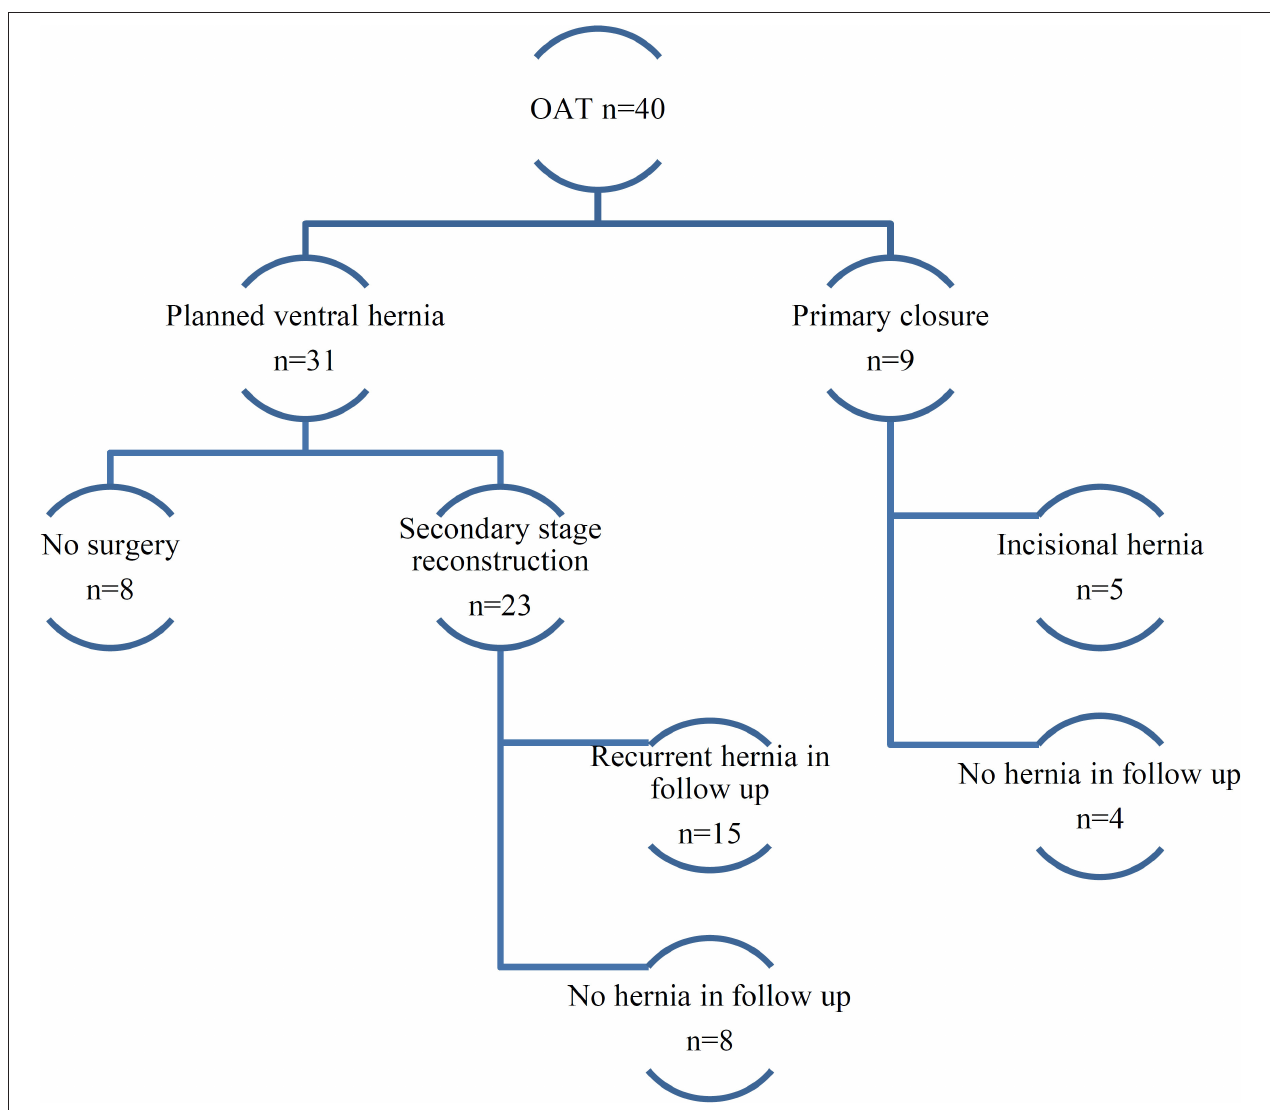
FIGURE 1 | Abdominal closure and hernia incidence after open abdomen treatment (OAT). The flowchart shows the results of OAT concerning primary closure, planned ventral hernia, and recurrent hernia